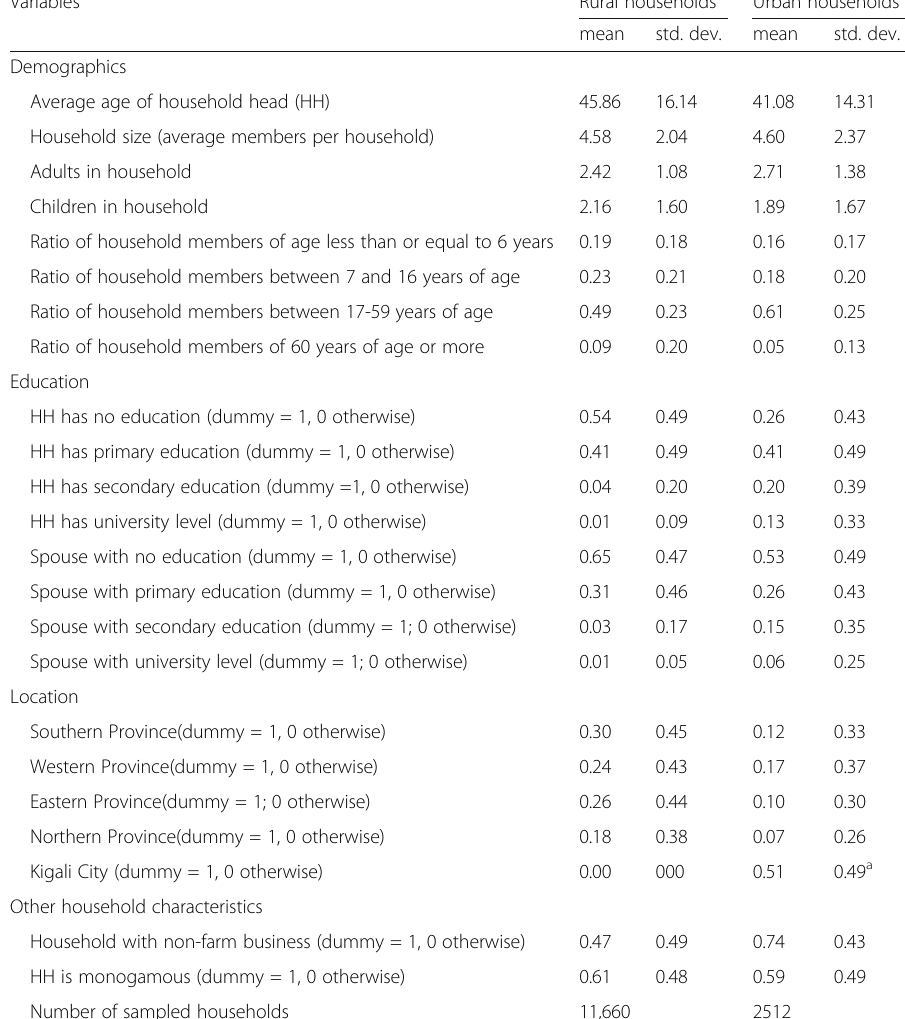
Table 1 Distribution of demographic and household characteristics in the study